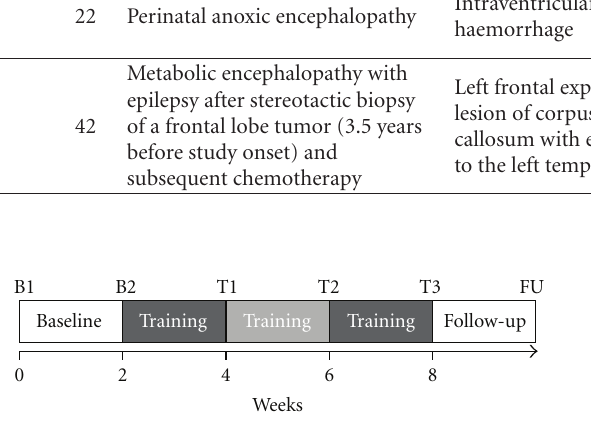
Figure 1: Timeline of climbing training and motor performance tests. B1, B2: baseline tests before training. T1, T2, T3: tests during and at the end of the training period. FU: follow-up test after